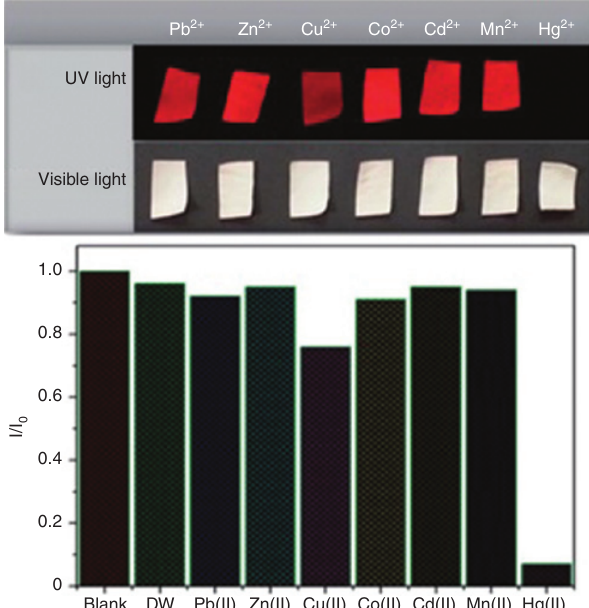
Figure 23: Sensing performance of AuNC*NFM upon exposure to different metal ions in water. The concentration of all metal ions was fixed at 10 ppm. Photographs were taken under UV and white light. For details, see Ref. [100]; reprinted with permission from Royal Society of